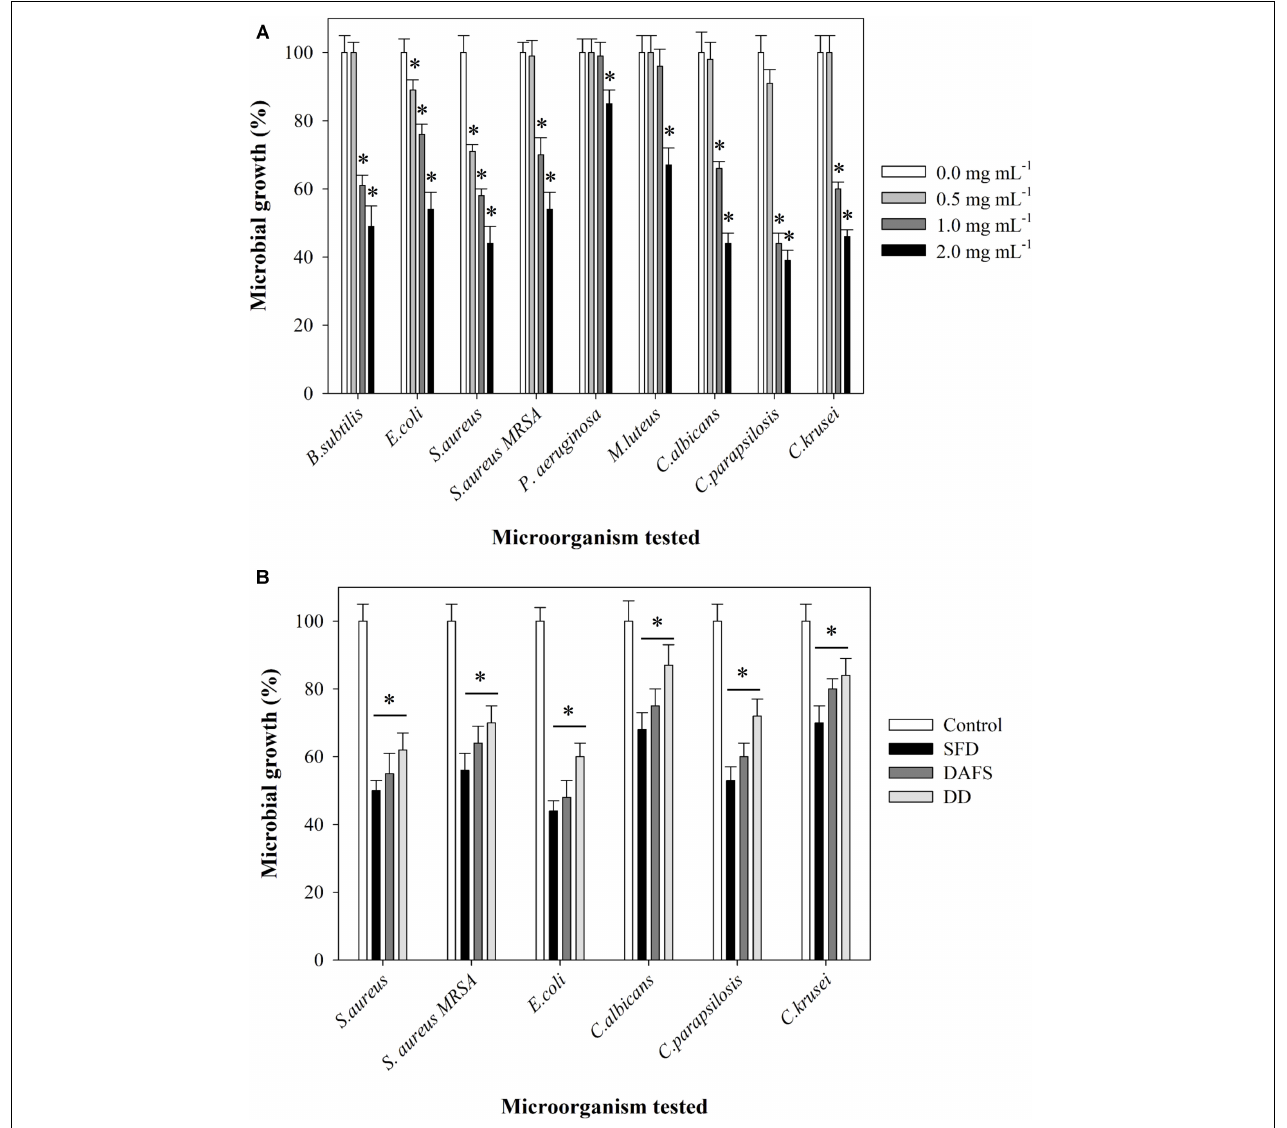
FIGURE 4 | Inhibition of microbial growth by (A) cell-free extract containing violacein at concentrations of 0.0, 0.5, 1.0, and 2.0 mg mL − 1 and (B) polyamide 6.6 fabrics dyed via SFD, DAFS, or DD or untreated fabric. Statistical significance ( p < 0.05) values from control are denoted by